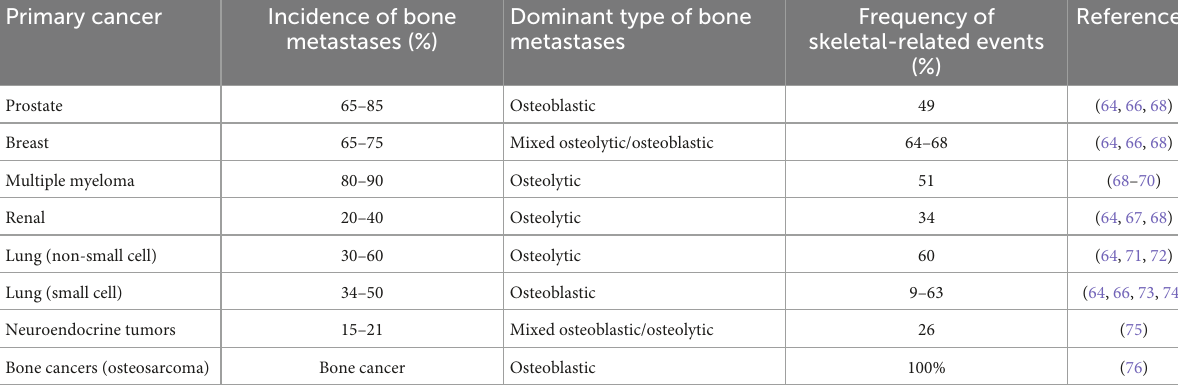
TABLE 2 Incidence of bone metastases in advanced cancer.